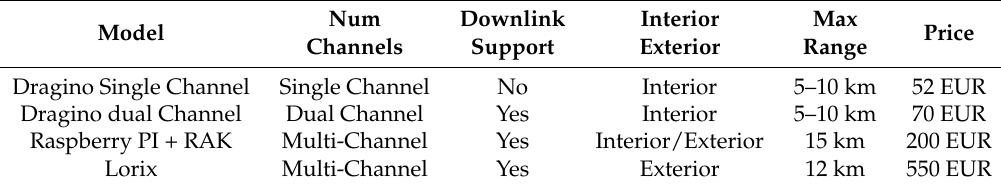
Table 3. Gateway